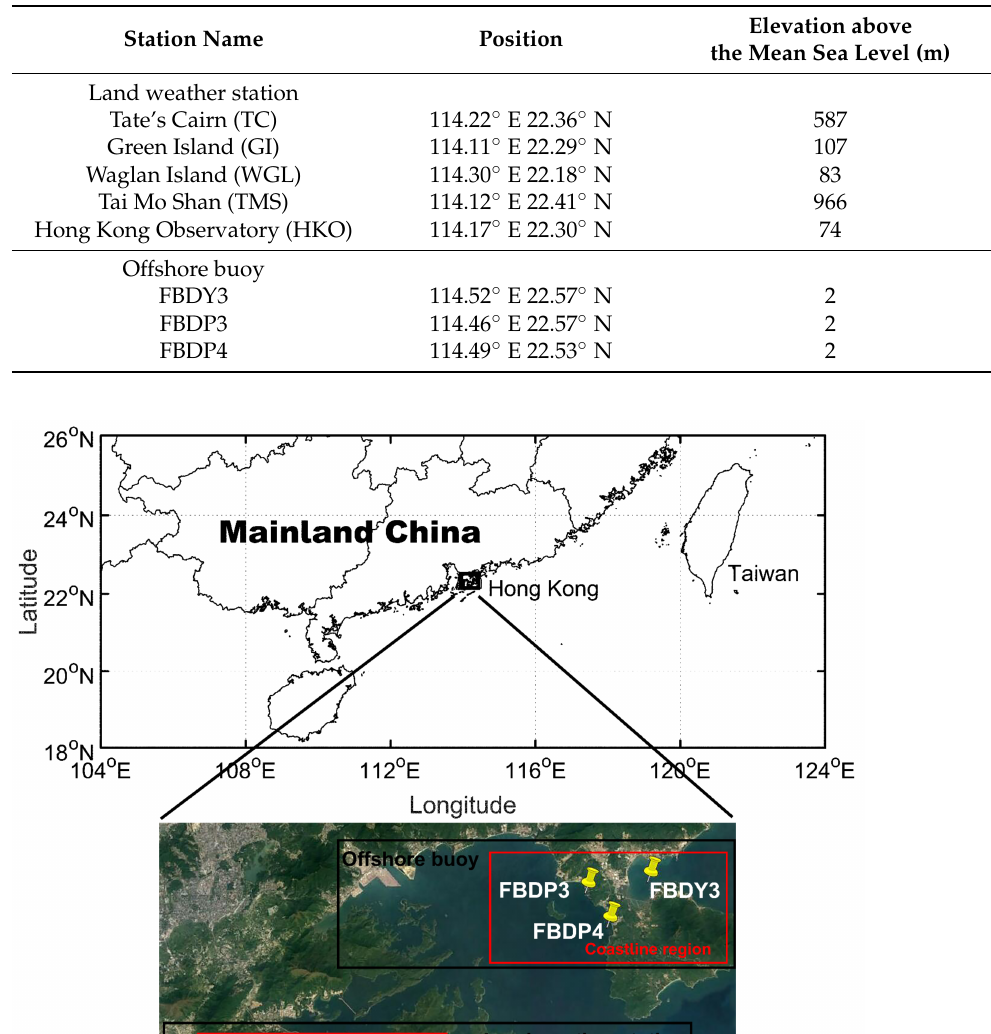
Table 4. Details of the land weather station and offshore buoys.